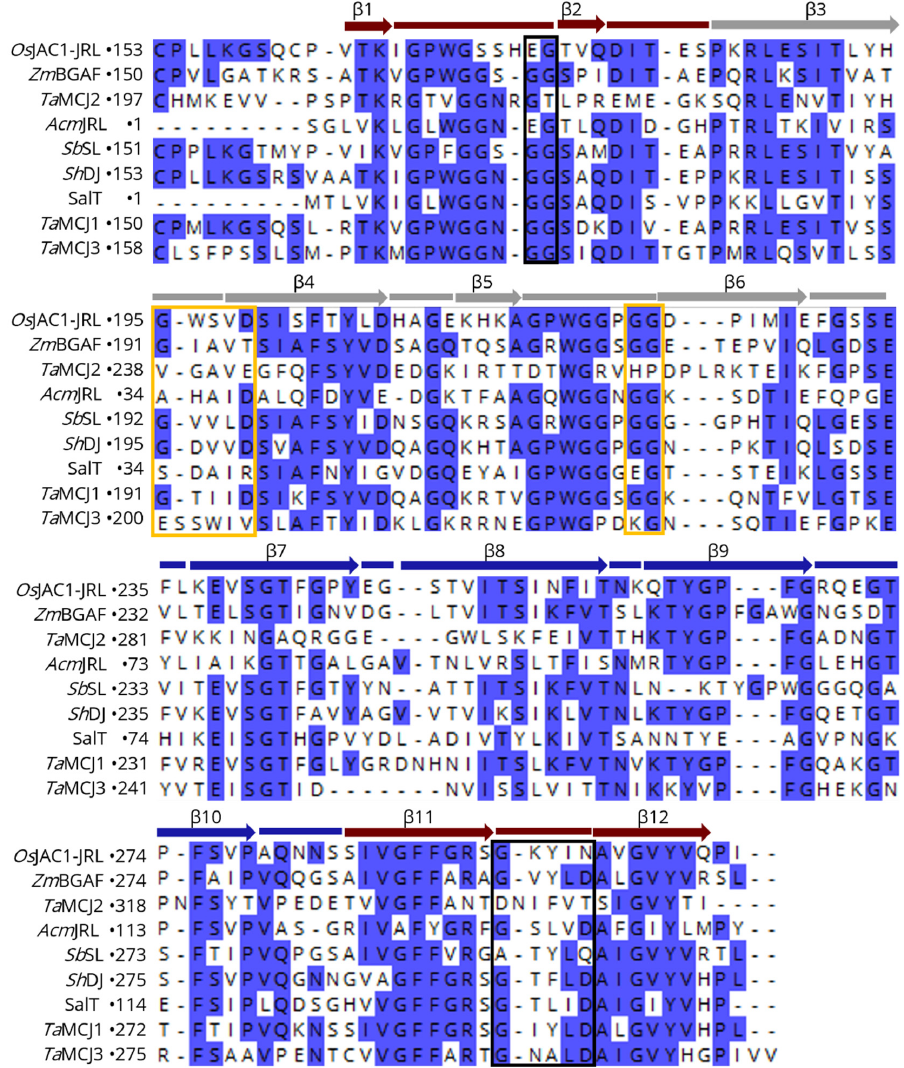
Figure 5. Sequence alignment (CLUSTAL OMEGA multiple sequence alignment [47] ) of the Os JAC1 ‐ JRL domain with different MCJ and mJRL proteins. Bars correspond to the loops and arrows to the β‐ strands of the Os JAC1 ‐ JRL domain (coloring indicates the three four ‐ stranded antiparallel β sheets (Greek key motifs I–III) as in Figure 1A). Black and yellow frames denote residues of proposed binding site I and binding site II, respectively, of the Os JAC1 ‐ JRL domain. Conserved regions (>50% identity) are shaded in blue. The sequences correspond to proteins from Zea mays ( Zm BGAF), Triticum aestivum ( Ta MCJ1, ‐ 2, ‐ 3), Ananas comosus ( Acm JRL), Sorghum bicolor ( Sb SL) Saccharum hybrid ( Sh DJ), and Oryza sativa (SalT).